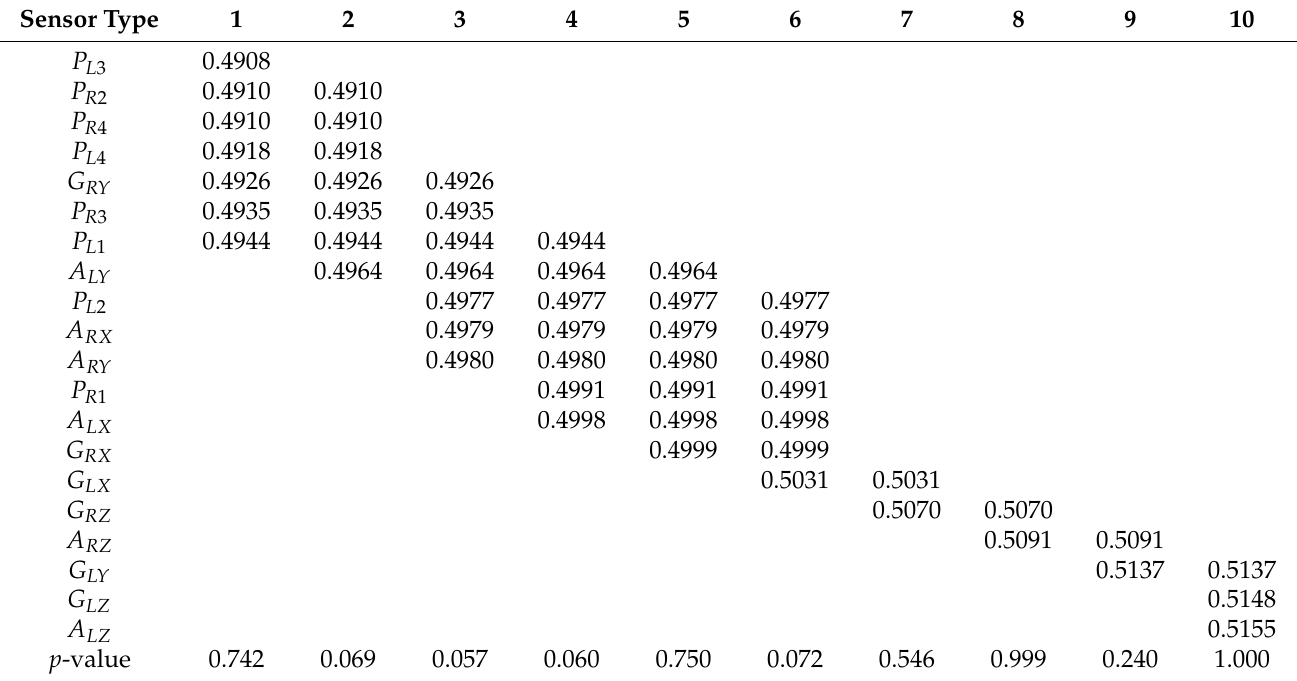
Table 4. Post-hoc Tukey HSD test result for the averaged attention weight for each sensor in EE estimation. Each column 1–10 represents a homogeneous subset for a significance level of 0.05. The sensor types are pressure (P), accelerometer (A), and gyroscope (G). The first subscript for each sensor type denotes the left (L) and right (R) sides of the shoe. The second subscript is the detailed attachment position of the pressure sensor (see Figure 2) or the x, y, and z axis directions of the accelerometer and